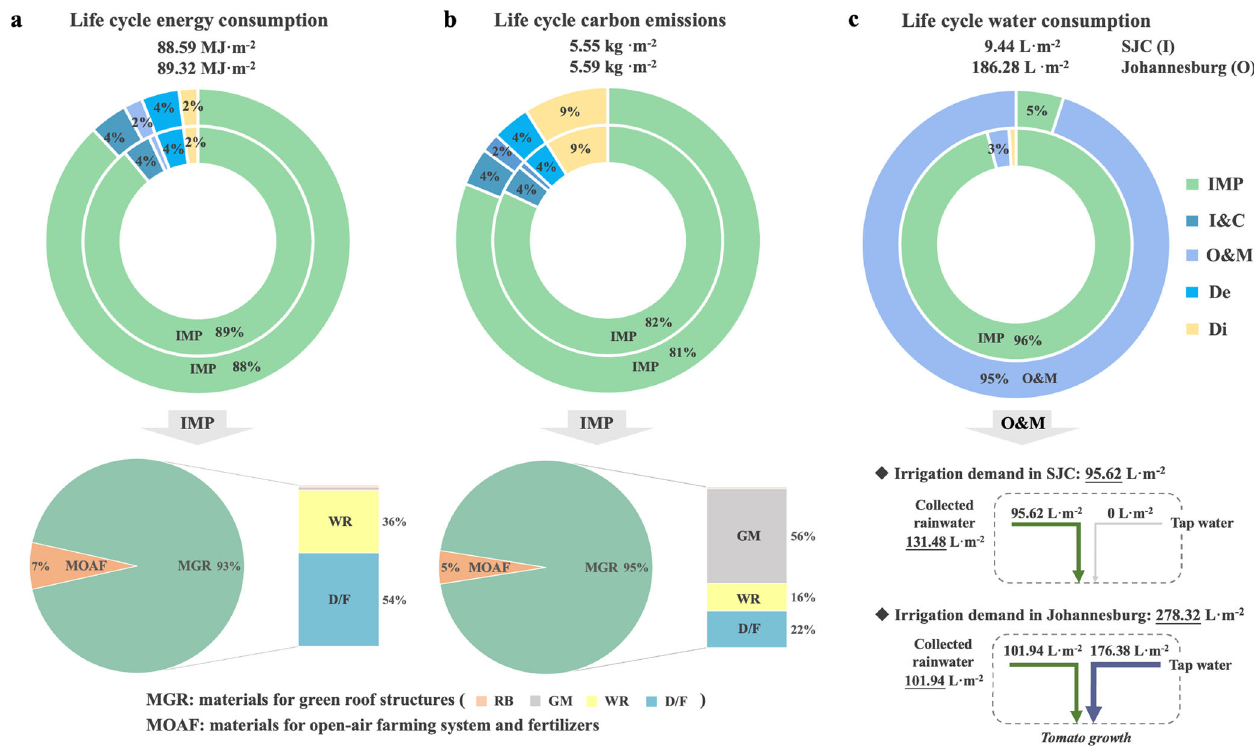
Fig. 3 Life cycle impacts of green roofs per square meter. Panels ( a ), ( b ), and ( c ) respectively show the life cycle energy consumption, carbon emissions, and water consumption of the green roof system from left to right. I inner circle, O outer circle, IMP infrastructure material production, I&C installation and construction, O&M operation and maintenance, De demolition, Di disposal, RB root barrier, GM growing medium, WR water retention, D/F drainage/ fi